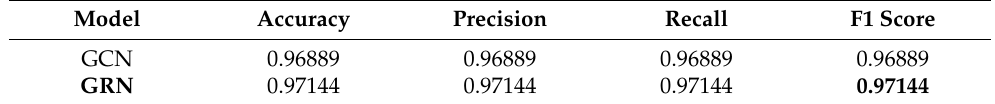
Table 10. The evaluation comparison of each model for aspect classification. Model